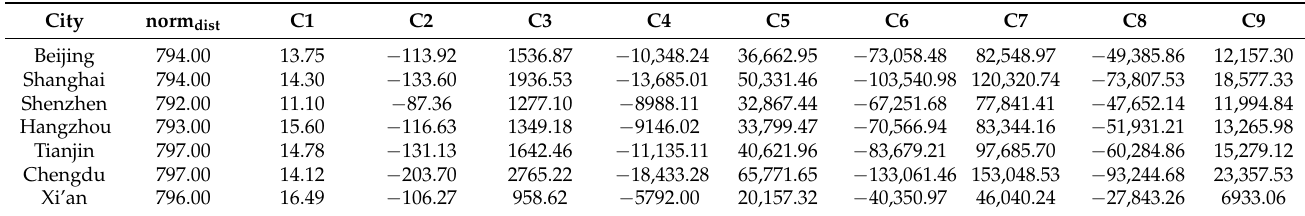
Table 7. Actual UF fitting